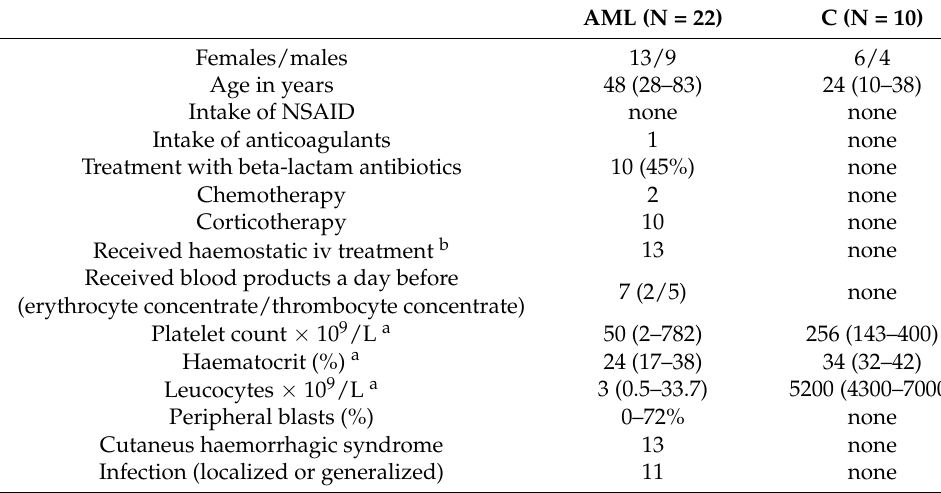
Table 1. Characteristics of patients with AML and